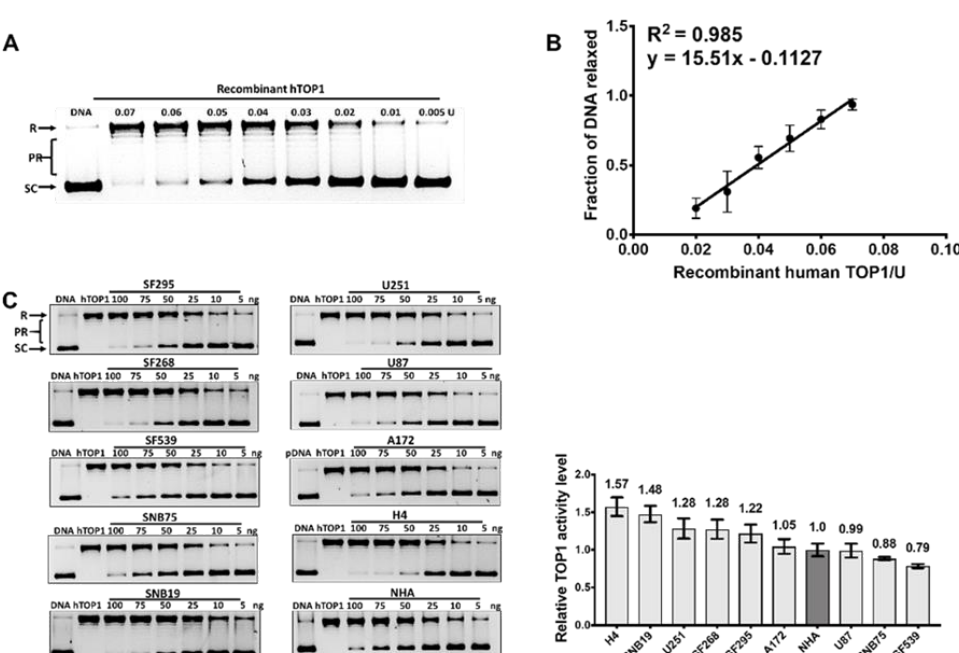
Figure 3. Topoisomerase I (TOP1) activity in GBM cell lines. ( A ) Supercoiled plasmid DNA was relaxed by serially diluted recombinant human topoisomerase I (hTOP1) and separated using gel electrophoresis. SC: supercoiled DNA, R: relaxed DNA, PR: partially relaxed DNA; ( B ) the fraction of DNA relaxed by the TOP1 activity was quantitated to generate a standard curve; ( C ) assay of relative TOP1 activity levels in serial dilutions of GBM WCEs. The bar graph shows the average and standard deviation as the error bar from at least three technical replicates.